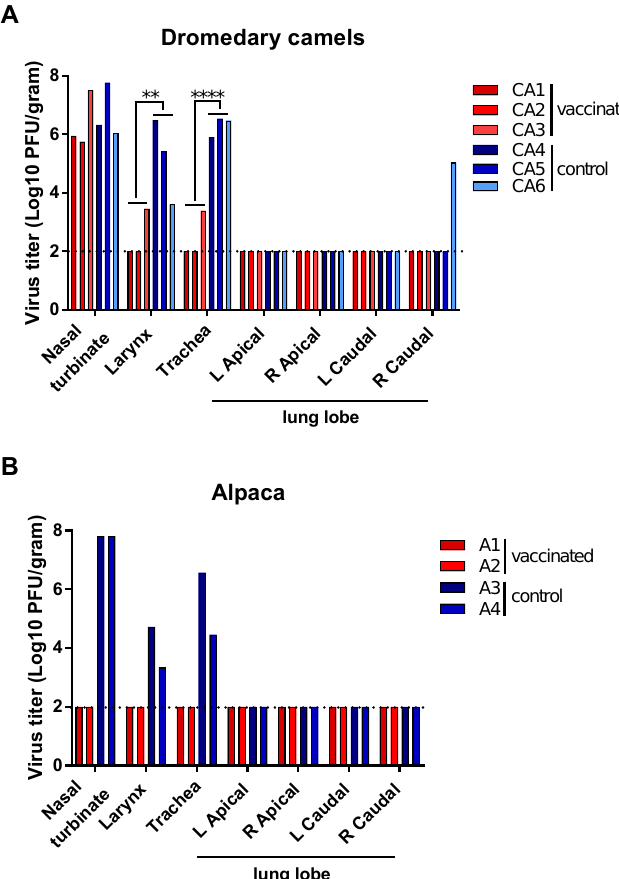
Figure 3. Infectious virus in respiratory tissues of vaccinated and unvaccinated dromedary camels and alpaca after challenge with MERS-CoV. Dromedary camels ( A ) and alpaca ( B ) were euthanized on 5 dpi, tissues were collected, and virus titers were determined in a plaque assay. Red bars indicate vaccinated animals and blue bars indicate unvaccinated control animals. A dashed line indicates the detection limit of the assay. Asterisks indicate statistically significant difference between geometric mean titers (** p < 0.01; **** p < 0.0001). L: left; R: right.